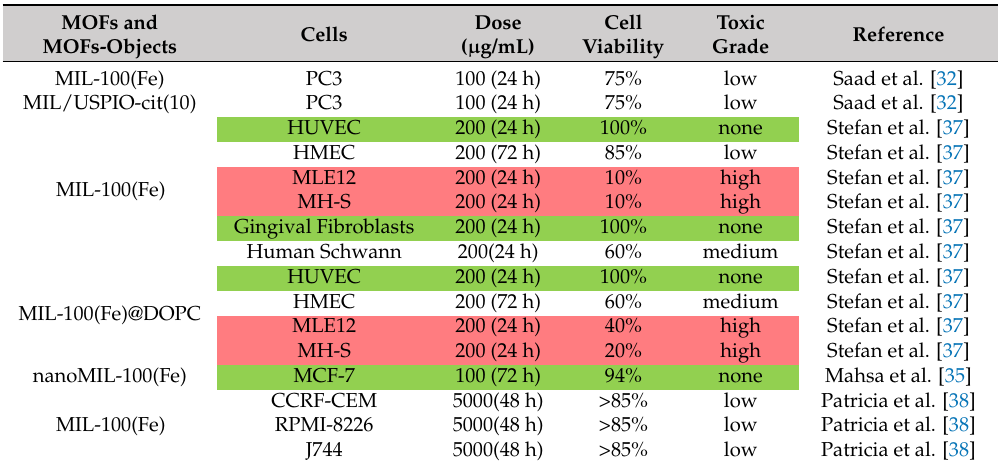
Table 1. The Effect of MIL-100 (Fe) on Various Cells,